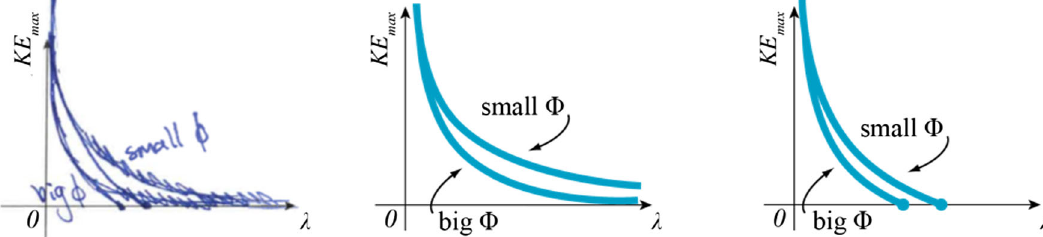
FIG. 8. Student work by Amanda. The leftmost picture is a scan of her actual work, showing her initial answer (the crossed-out plots) and her final answer. For clarity, we have included plots separating her initial sketch (center) and the group ’ s final answer